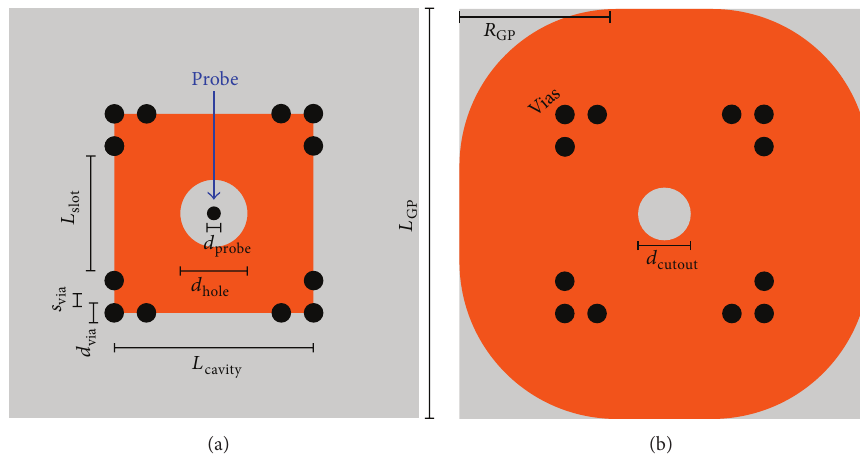
Figure 3: Geometry of the proposed substrate-integrated cavity monopole antenna: (a) top layer, (b) bottom layer.